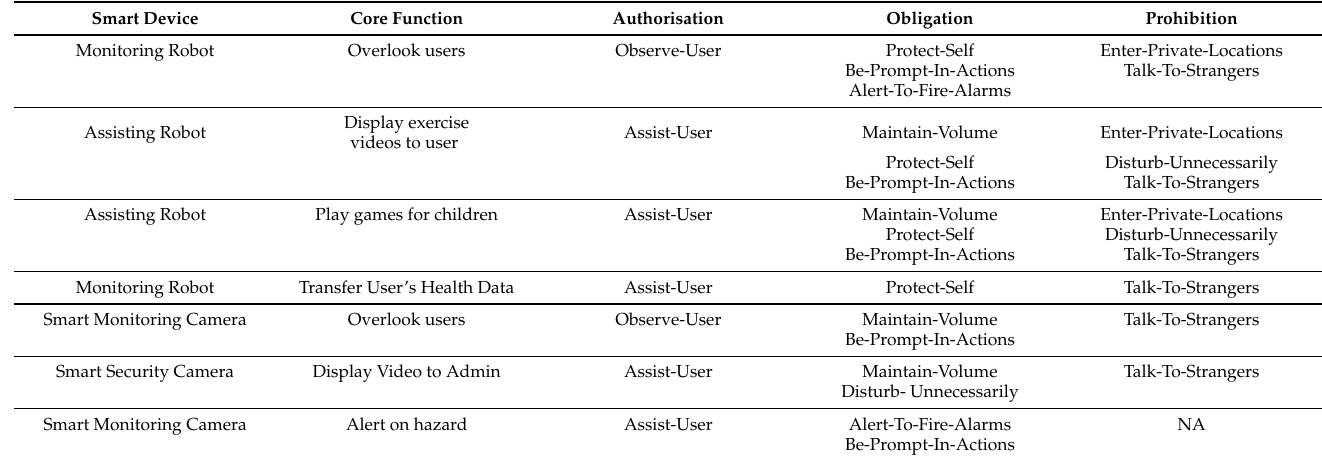
Table 6. Administrative policy rules and core functions mapping—children’s